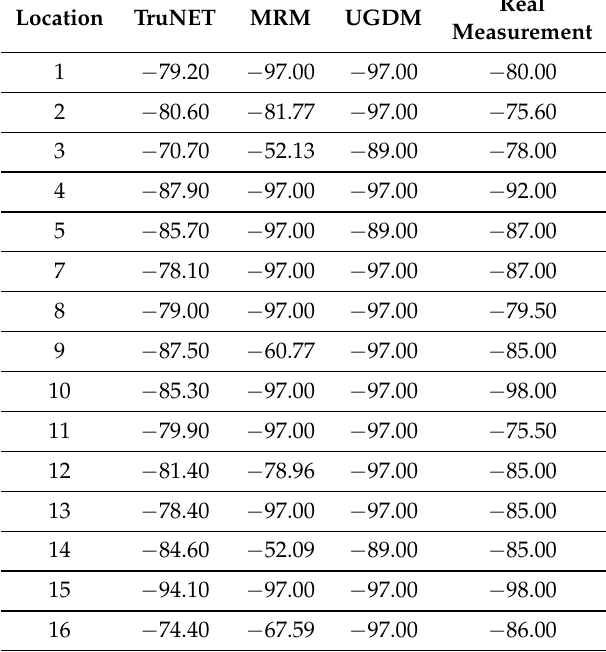
Table 3. RSS Comparison—WSN Setup I.